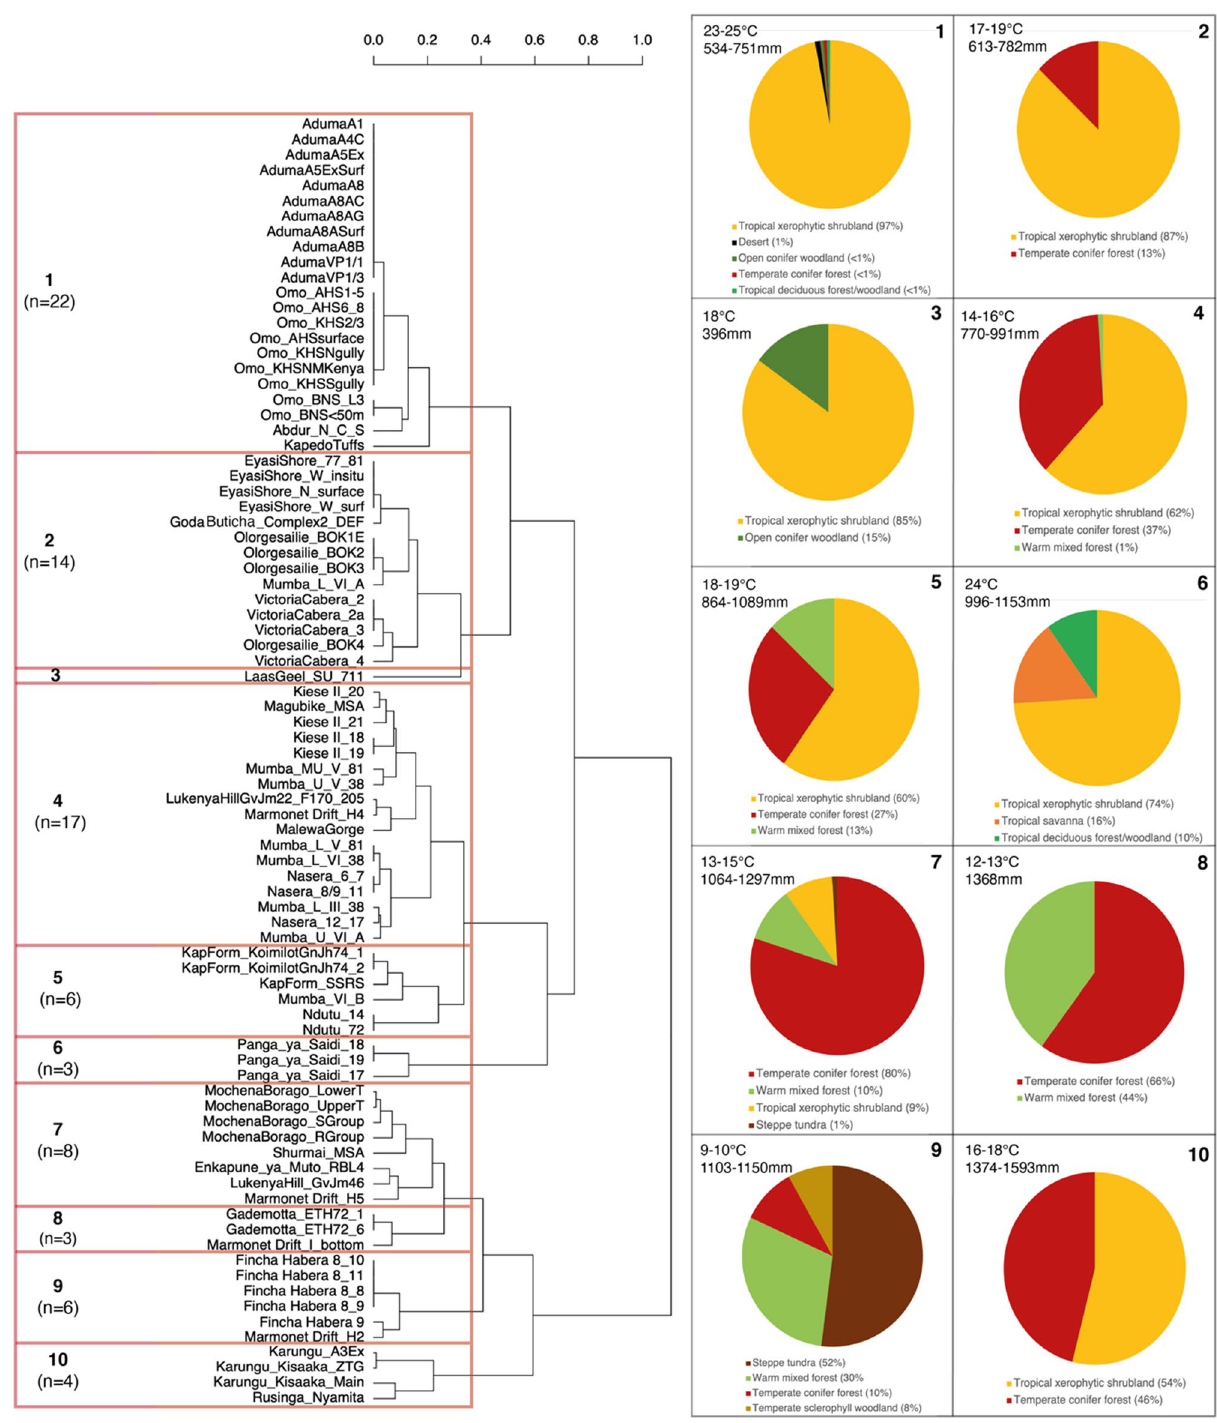
Figure 4. Hierarchical clustering of the occupations according to mean annual temperature and total annual precipitation. K means clustering identified ten clusters as the optimal division of the dendrogram, which have been highlighted here as well as the range of environmental conditions occupied by each cluster and the percentage of cells within 50 km of that biome for all occupations within that